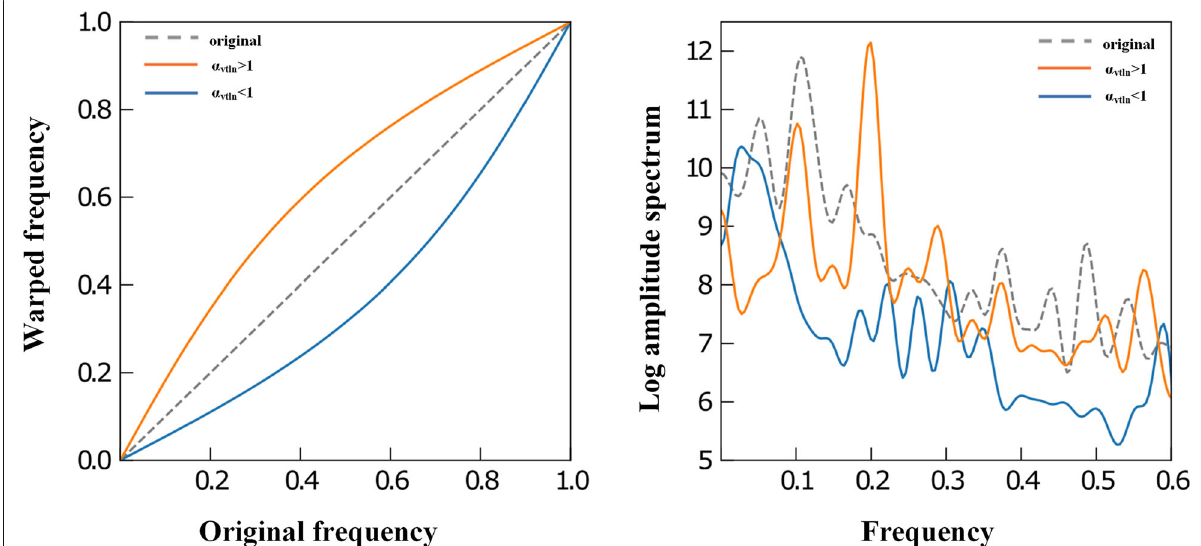
Fig. 2 Examples of VTLN: description of the warping function (left) and the change in the spectral curve after application